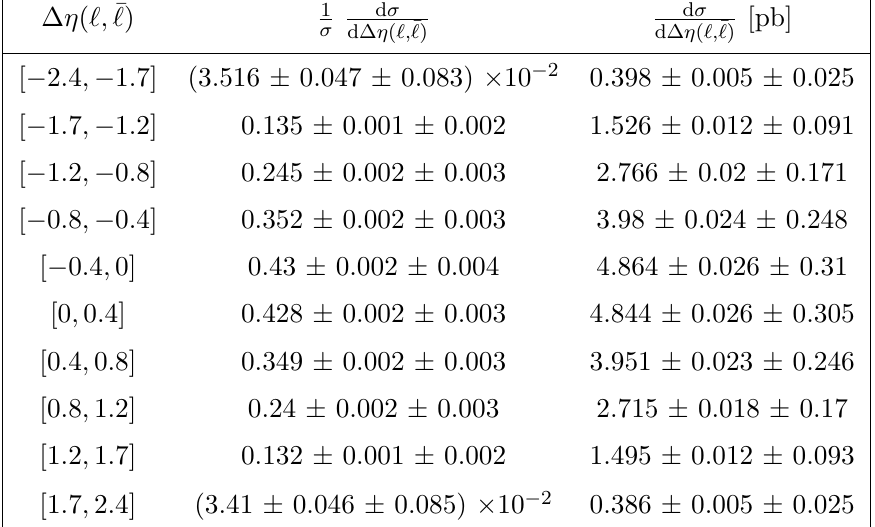
Table 40 . The measured di(cid:11)erential cross section and bin boundaries for each bin of the normalized and absolute measurements of the tt di(cid:11)erential cross section at particle level in the (cid:12)ducial phase space as a function of (cid:1) (cid:17) ( ‘; (cid:22) ‘ ) are tabulated.